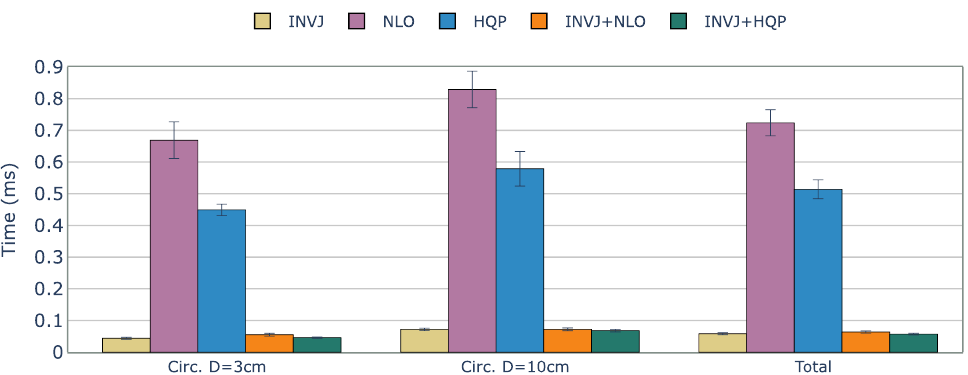
Figure 5. Average runtime (ms) of successful IK solves for a constrained tracking task with KC-1 (endoscope holder) kinematic chain. The best time performance is achieved by the INVJ-based IK solvers with average solving times of 0.07